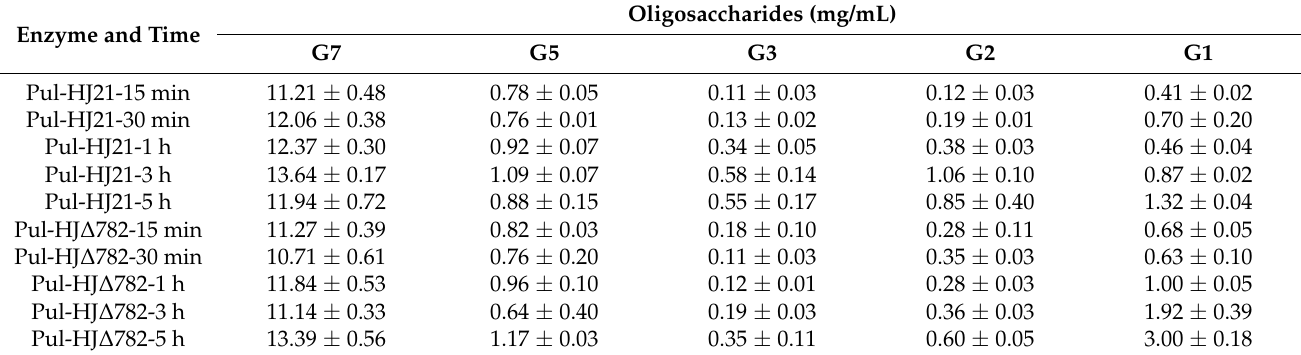
Table 3. Concentration of hydrolysates after the enzymatic digestion of soluble starch at different times by Pul-HJ21 and Pul-HJ ∆ 782.